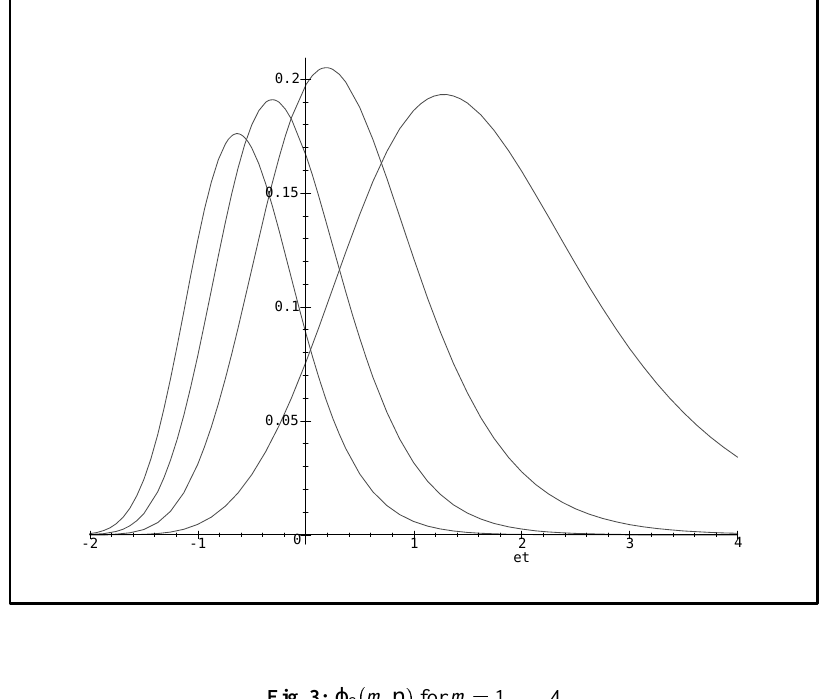
Fig. 3: j 2 (cid:0) m